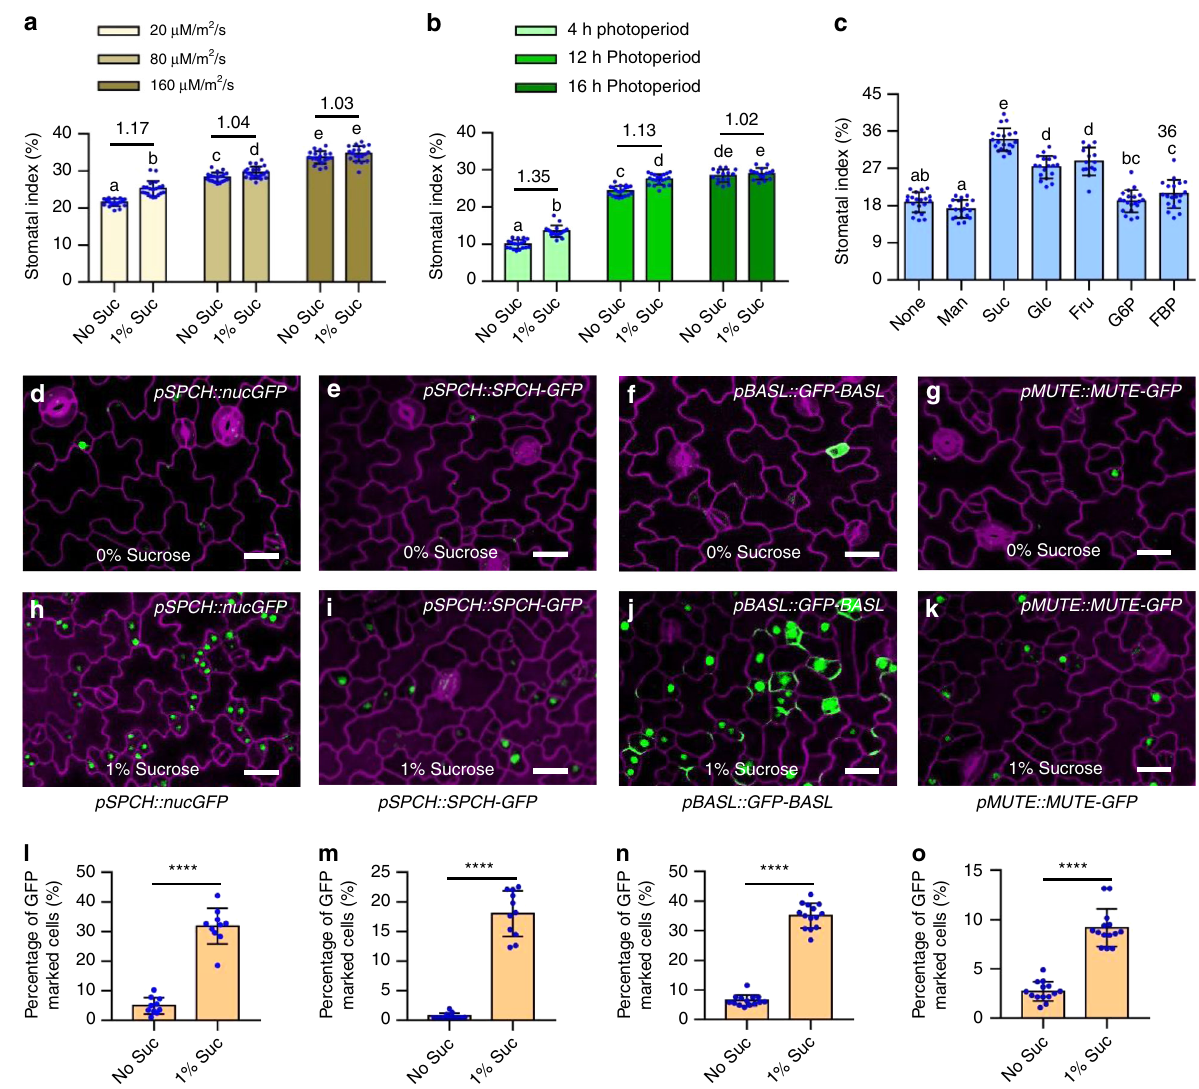
Fig. 1 Sucrose promotes stomatal development and alters cell fate in Arabidopsis epidermis. a The stomatal index changes in response to light quantity. Seedlings of wild-type plants were grown on ½ MS solid medium with or without 1% sucrose under 16 h light/8 h dark photoperiod with different light intensity for 10 days. b Quanti fi cation of the effects of photoperiod and exogenous sucrose on stomatal development. Seedlings of wild-type plants were grown on ½ MS solid medium with or without 1% sucrose under different photoperiod with 100 µ Mol m − 2 s − 1 for 10 days. Numbers between bars indicated the relative fold changes of average means in the indicated conditions. c Quanti fi cation of the effects of different sugars on stomatal index. Seedlings of wild type Col-0 were grown in ½ MS liquid medium containing 30 mM mannitol (Man, 0.55%), sucrose (Suc, 1%), glucose (Glu, 0.54%), fructose (Fru, 0.54%), glucose-6-phosphate (G6P, 0.78%), and fructose-1,6-bisphosphate (FBP, 1%) under 16 h light/8 h dark photoperiod with 100 µ Mol m − 2 s − 1 continuously for 10 days. Error bars indicate standard deviation (S.D.) ( n = 15 – 20). Different letters above the bars indicated statistically signi fi cant differences between the samples (ANOVA analysis followed by Uncorrected Fisher ’ s LSD multiple comparisons test, p < 0.05). d – o Sucrose alters cell fate in Arabidopsis epidermis. Seedlings of pSPCH::nucGFP , pSPCH::SPCH-GFP, pBASL::GFP-BASL and pMUTE::MUTE-GFP were grown in ½ MS liquid medium with or without 1% sucrose for 3 days under long-day condition. Quanti fi cation of the percentage of GFP-expressing cells over total epidermal cells of different transgenic plants. The fl uorescent signals of GFP or GFP fused proteins are in green, PI-marked cell outlines are in purple. Scale bars in confocal images represent 20 μ m. Error bars indicate S.D. ( n = 15 – 20). Asterisk between bars indicated statistically signi fi cant differences between the samples (Student t test, **** p <